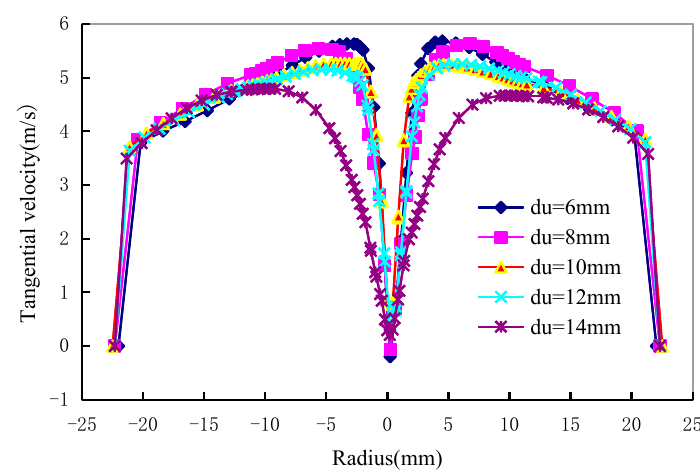
Figure 5. Tangential velocity profiles at several spigot diameters.